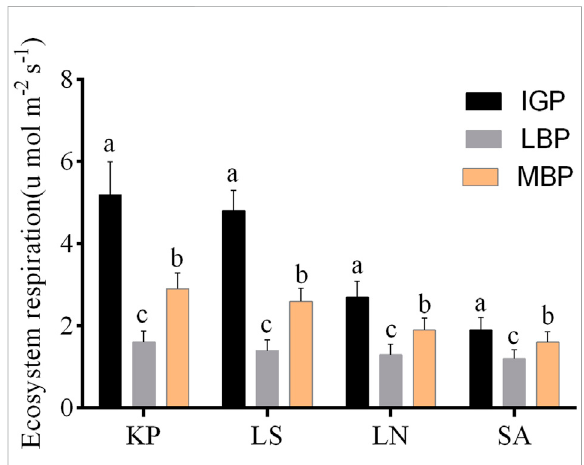
FIGURE 6 Ecosystem respiration of the various grass species patches. Bars with different letters show signi fi cance at p < 0.001. IGP; intactvegetationpatch,LBP;largestrippedvegetationpatch,MBP; medium stripped vegetation patch, KP; Koeleria pers patch, LS; Leymus secalinus patch, LN; Leontopodium nanum patch, SA; Stipa aliena patch.